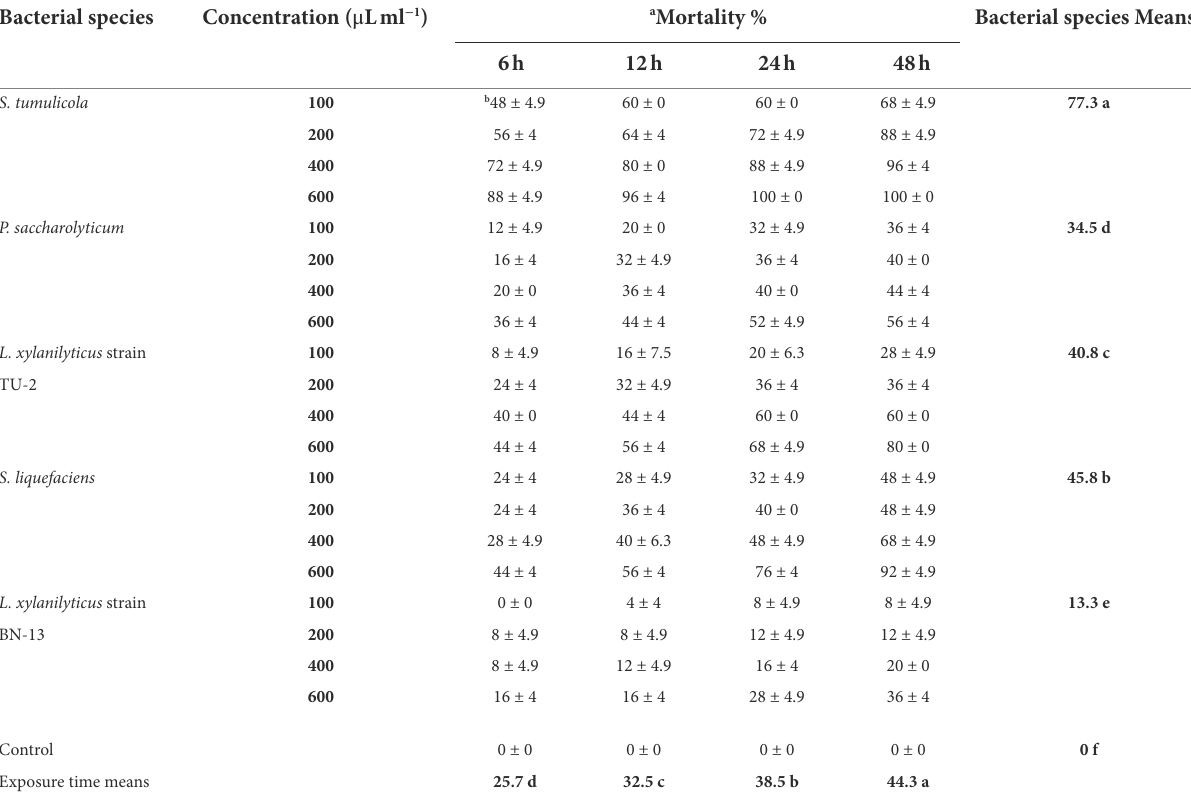
TABLE 8 Aphicidal activity of five bacterial species filtrates on the pomegranate aphid, A. punicae under laboratory condition. Bacterial